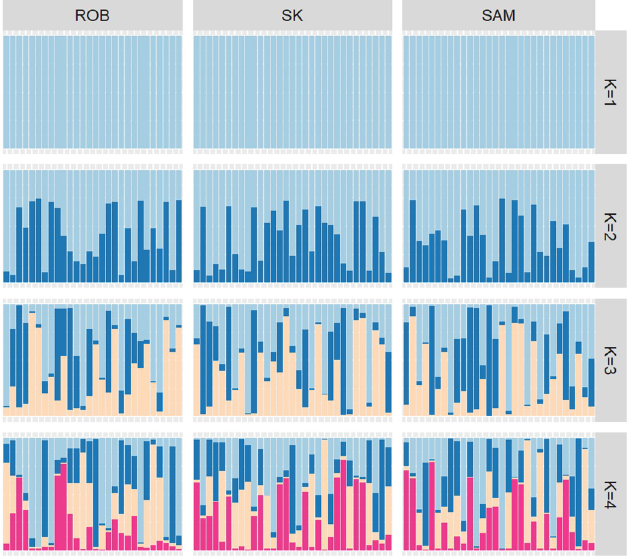
Fig 3. Population structure of the sea urchin C . sylviae inferred using the software STRUCTURE for K = 1 to K = 4 of 89 individuals from the three studied islands. A vertical line represents each individual, and each color represents the probability of belonging to one of the genetic clusters. ROB = Robinson Island, SAM = San Ambrosio Island, and SK = Selkirk Island.